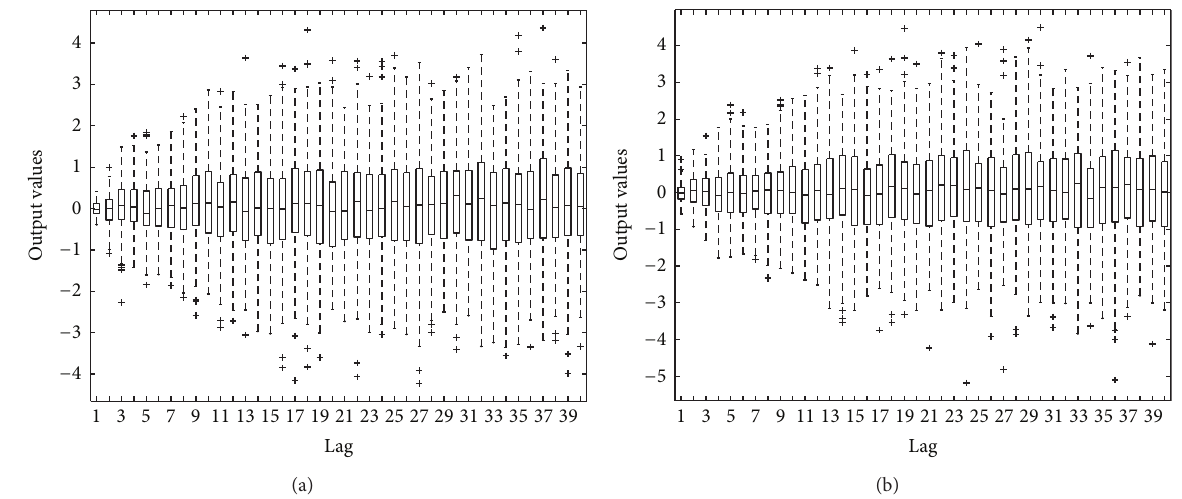
Figure 4: Box plots for closed-loop system output on memory length 𝑡 = 1,...,40 . (a) 𝑏 = 3 , 𝑙 = 5 ; (b) 𝑏 = 5 , 𝑙 = 3 .